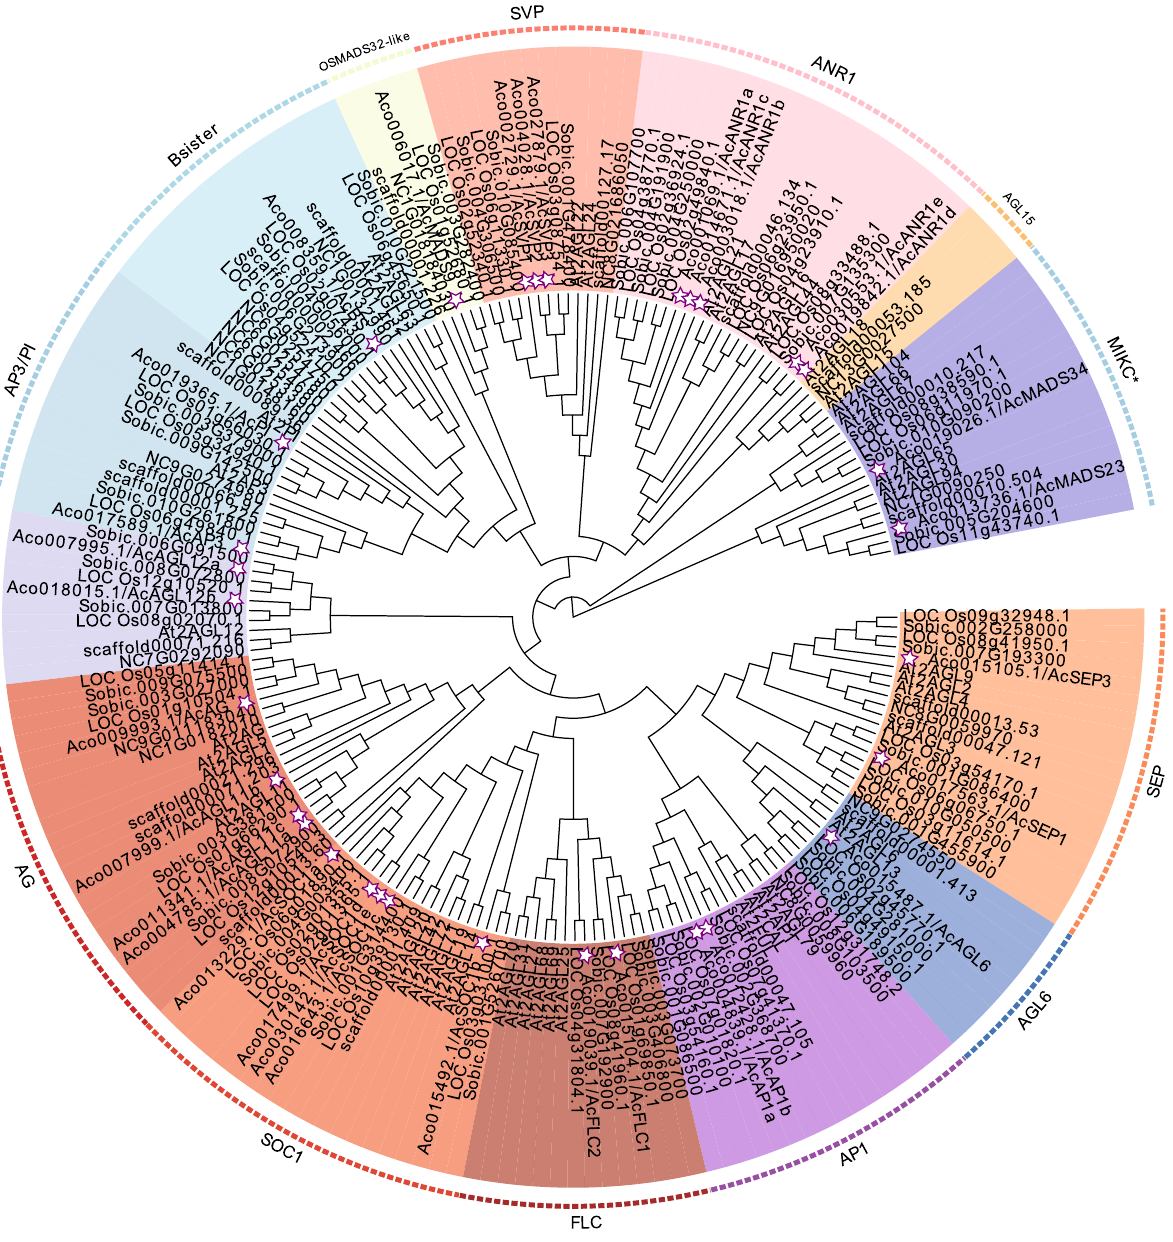
Figure 3. Phylogenetic relationships of type II MIKC C MADS-box proteins in six species. The tree was generated after multiple sequence alignment using MAFFT and the ML method. Fourteen clades are marked with different colors, and the pineapple MADS-box genes are indicated by red dots. The species are abbreviated as follows in the gene names: pineapple, Ac; Amborella , Scaffold; waterlily, Nc; Arabidopsis , At; rice, Loc_Os; and sorghum,